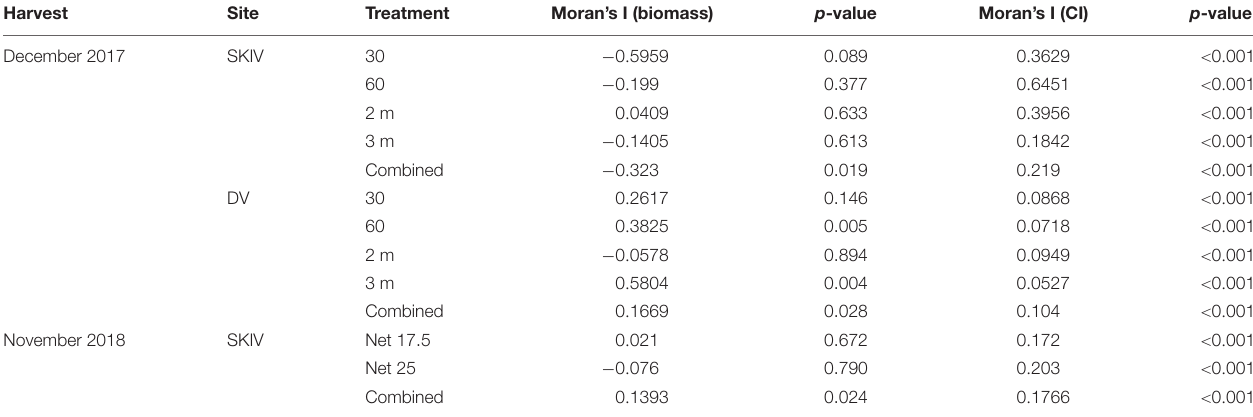
TABLE 2 | Spatial autocorrelation (Moran’s Index) of biomass per meter substrate (kg m − 1 ) and Condition Index distributed over the farm. Harvest Site Treatment Moran’s I